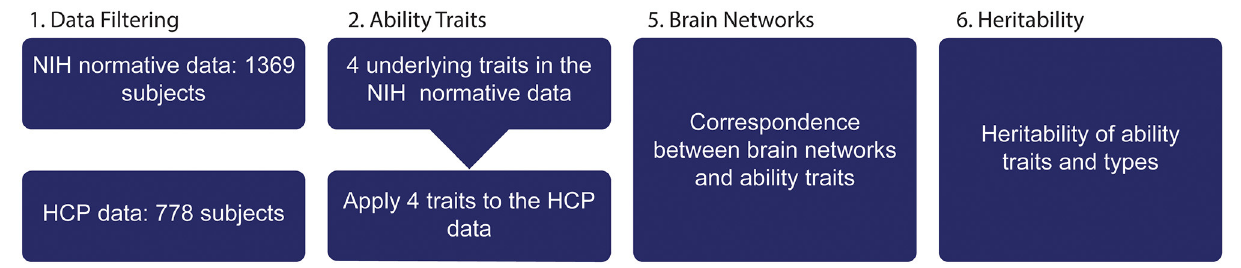
FIGURE 1 | Structure of paper. (1) NIH toolbox data from Normative study and HCP was filtered, only ability data were included in the initial analysis. (2) A dimensionality reduction of the 31 variables was performed exposing four ability traits. (3) The HCP dataset is used to link brain features to ability traits and (4) to determine heritability of individual ability traits and brain